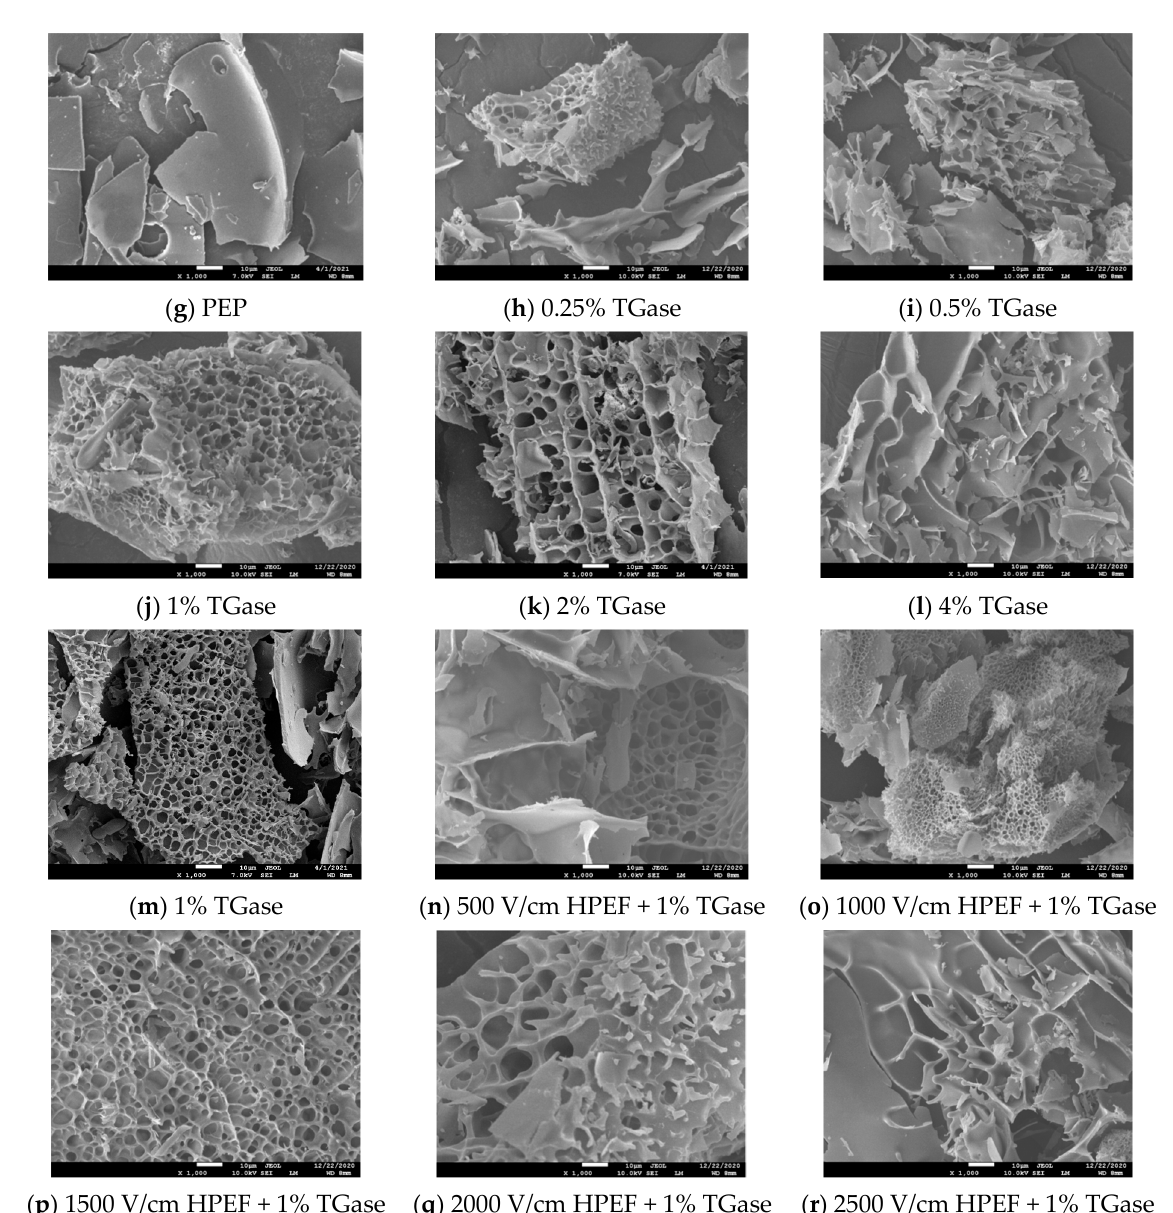
Figure 2. The effects of HPEF (500, 1000, 1500, 2000, and 2500 V/cm) addition (×500), TGase (0.25, 0.5, 1, 2, and 4%) (×1000), and compound treatment (HPEF-500, 1000, 1500, 2000, 2500 V/cm; 1% TGase) (×1000) on the micromorphology of PEP.